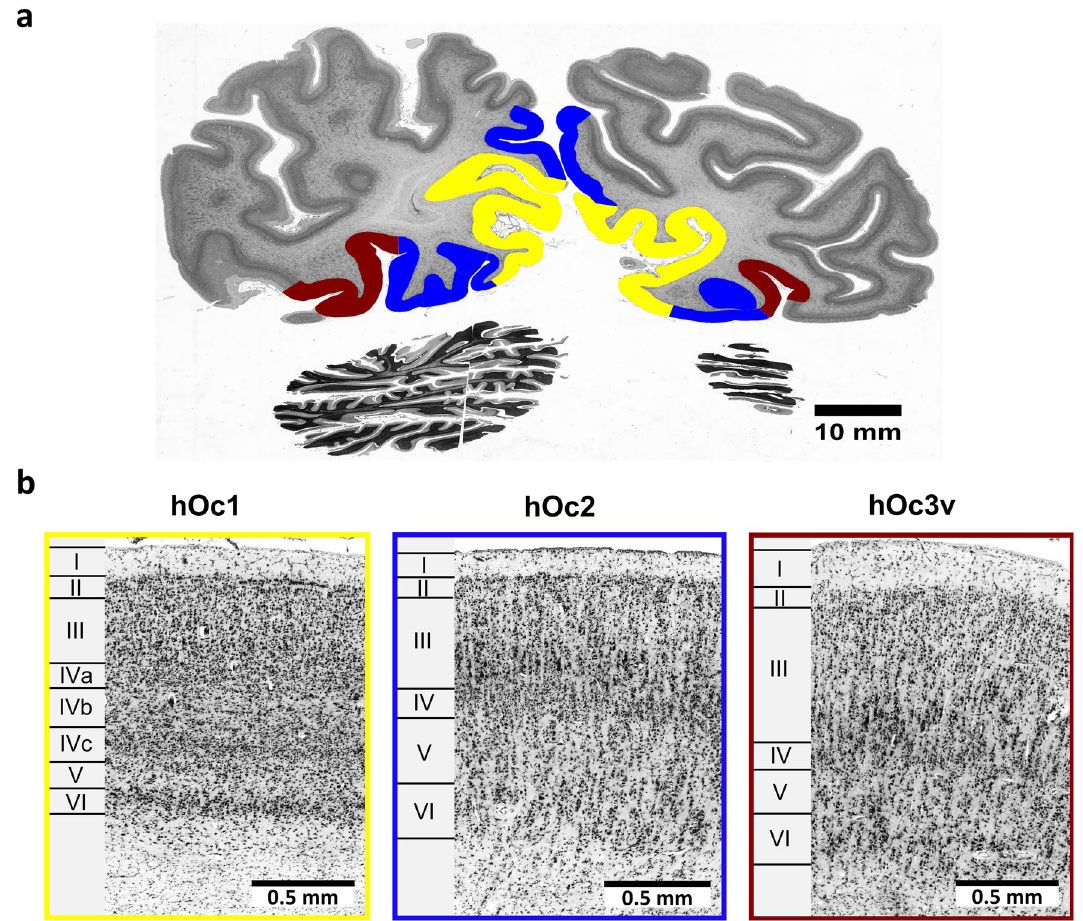
Figure 1. Cytoarchitecture of cortical areas of the visual system. ( a ) Histological cell-body stained section (section 901) from the occipital lobe of the BigBrain dataset with cortical areas hOc1 (yellow), hOc2 (blue) and hOc3v (brown) 16,17 . ( b ) Cytoarchitecture of cortical areas hOc1, hOc2 and hOc3v extracted from ( a ). Roman numerals indicate cortical layers. Area hOc1 is characterized by a prominent cortical layer IV, subdivided into sublayers IVa, IVb and IVc. Sublayer IVc shows the highest cell-density and constitutes the cortical input